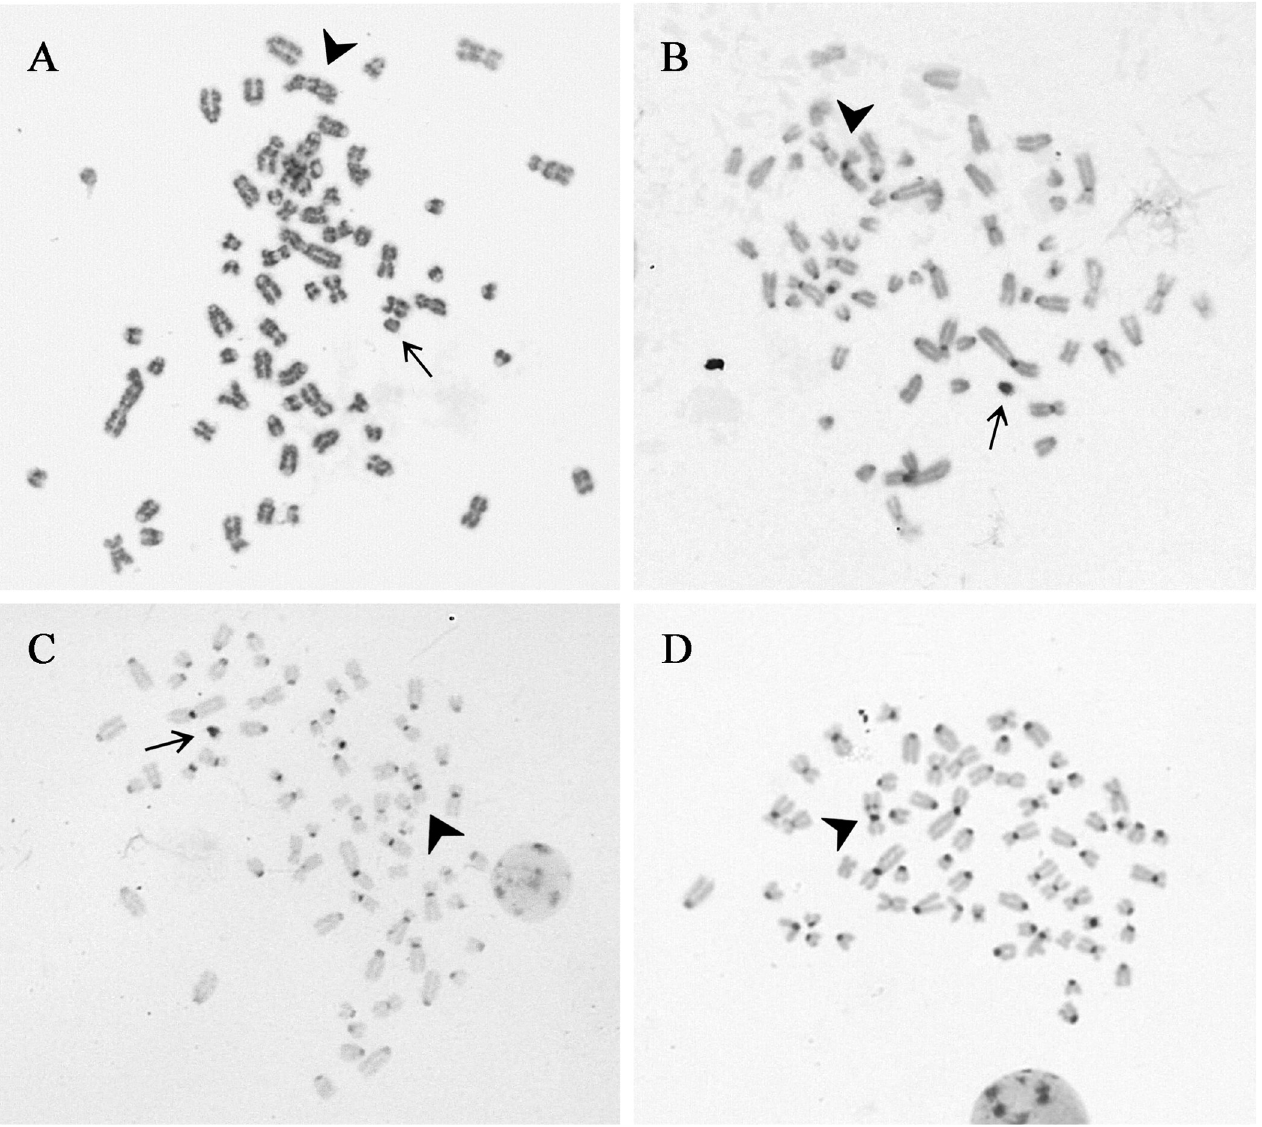
Fig 3. Representative metaphase spreads from the foals and the donor MSCs. (A) G banding and (B) C banding from the MSCs used as nuclear donors (64, XY). (C) C banding from the male clone (64,XY). (D) C banding from the female clone (63,X). Arrows indicate the Y chromosome and arrowheads indicate the X chromosome. Magnification